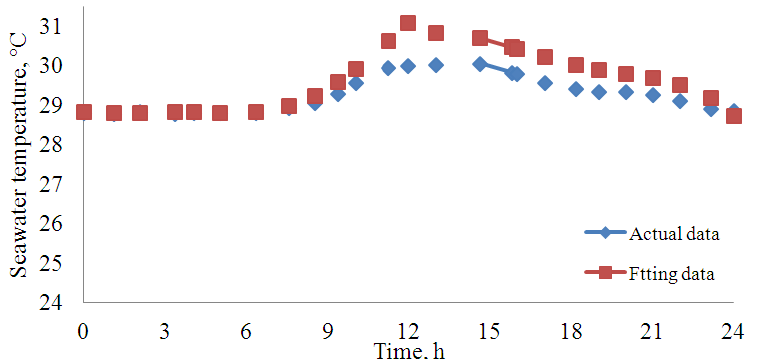
Figure 2. Seawater temperature profile during the day and